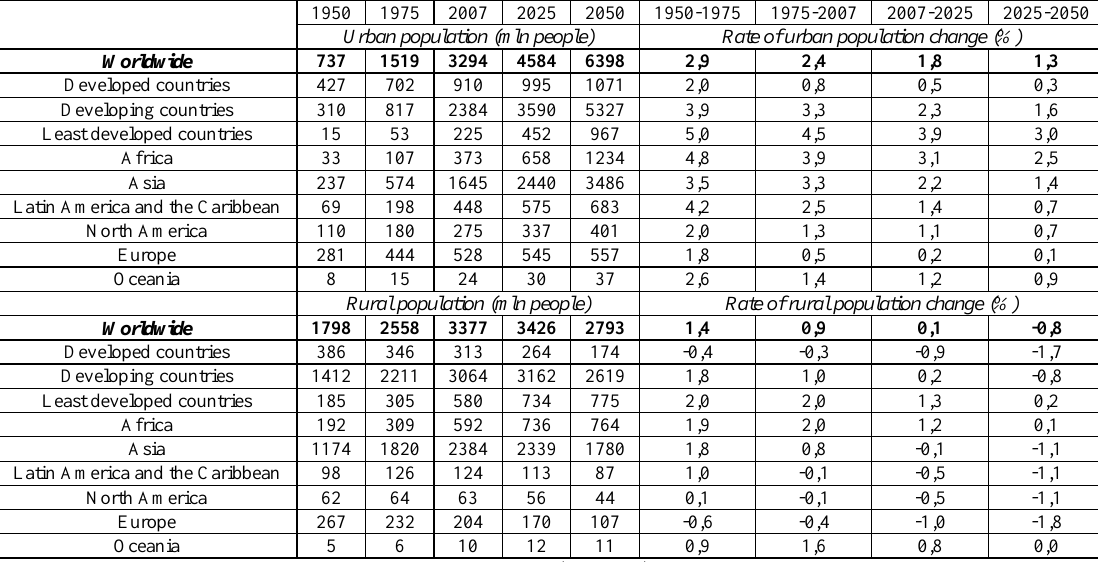
Table 1. Dynamics of urban and rural population, 1950-2050